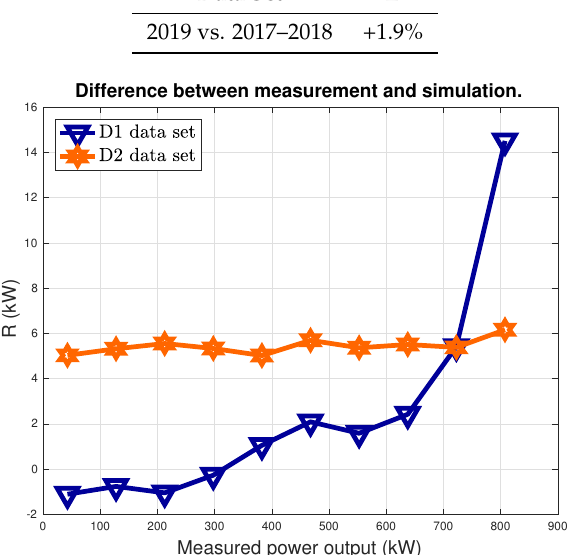
Figure 5. The average difference R between power measurement Y and estimation ˆ Y (Equation (14)). Data sets: 2017–2018 and